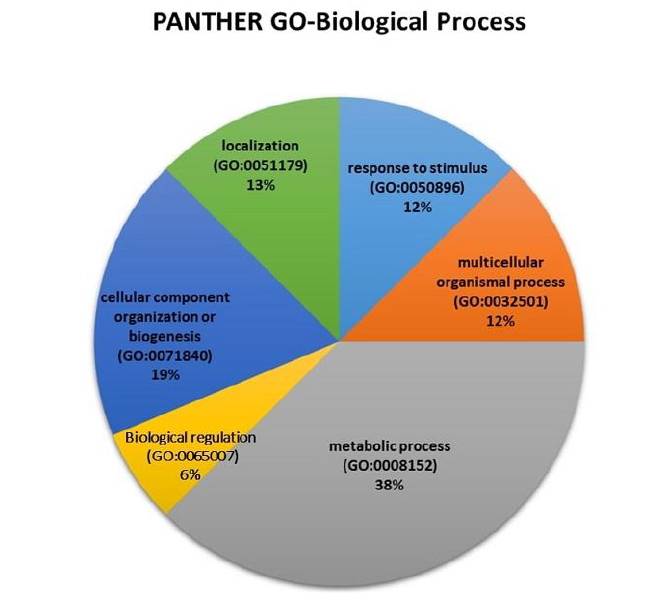
Figure 9. Biological process for the differentially expressed proteins. Biological processes for the differentially expressed proteins identified from the label free quantification approach. The pie chart was generated using PANTHER GO-classification system software.